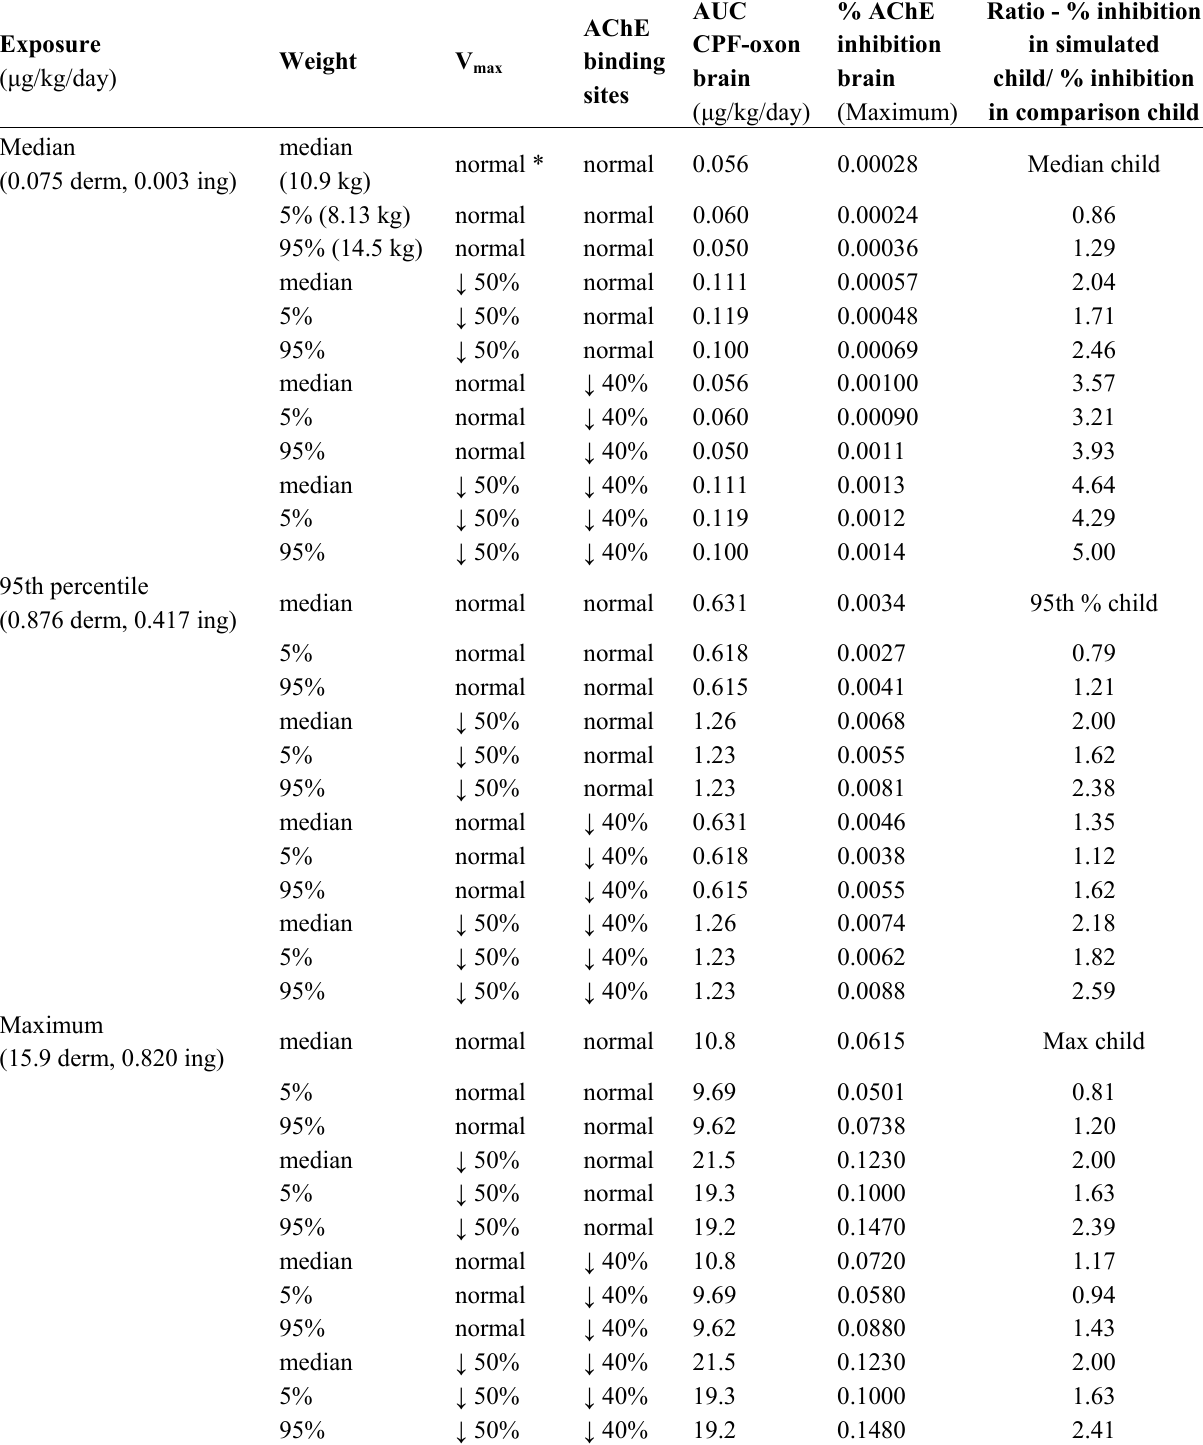
Table 1. Percent AChE inhibition changes in the brain after 21 day CPF exposure with inclusion of a chemical and non-chemical